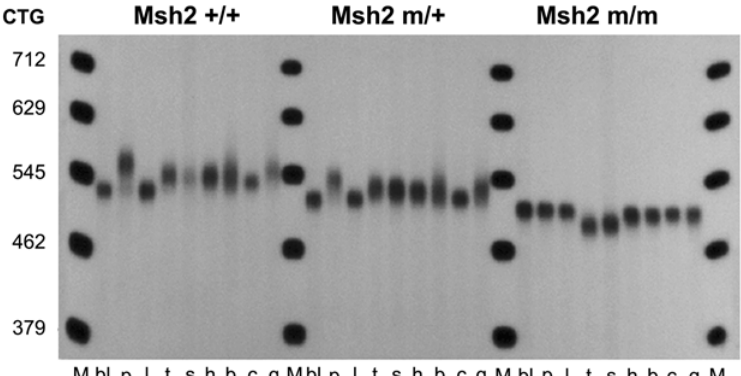
Figure 2. Somatic mosaicism in 8-month-old Msh2 + / + , Msh2 G674A/ + and Msh2 G674A/G674A transgenic males. bl, blood; p, pancreas; l, liver; t, testis; s, sperm; h, heart; b, brain; c, cerebellum; q, quadriceps. M. 250 bp DNA ladder converted to number of CTG repeat units in the given PCR product. Msh2 + / + /, m/ + and m/m represent genotypes at the murine locus for Msh2 . + : wild-type allele; m: Msh2 G674A mutation. The Msh2 + / + , m/ + and m/m males in tail extracted DNA at weaning contained 525, 516 and 500 CTG repeats, respectively.